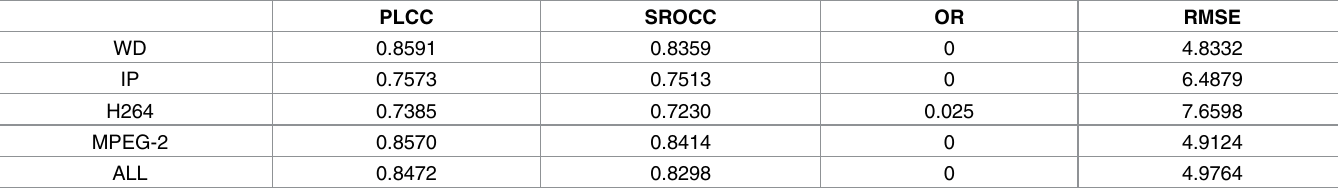
Table 3. Performanceon separatetypes of distortion.